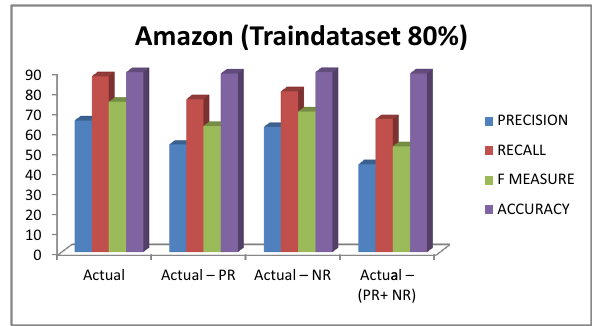
Figure 6: Plot for Amazon 80% train dataset.